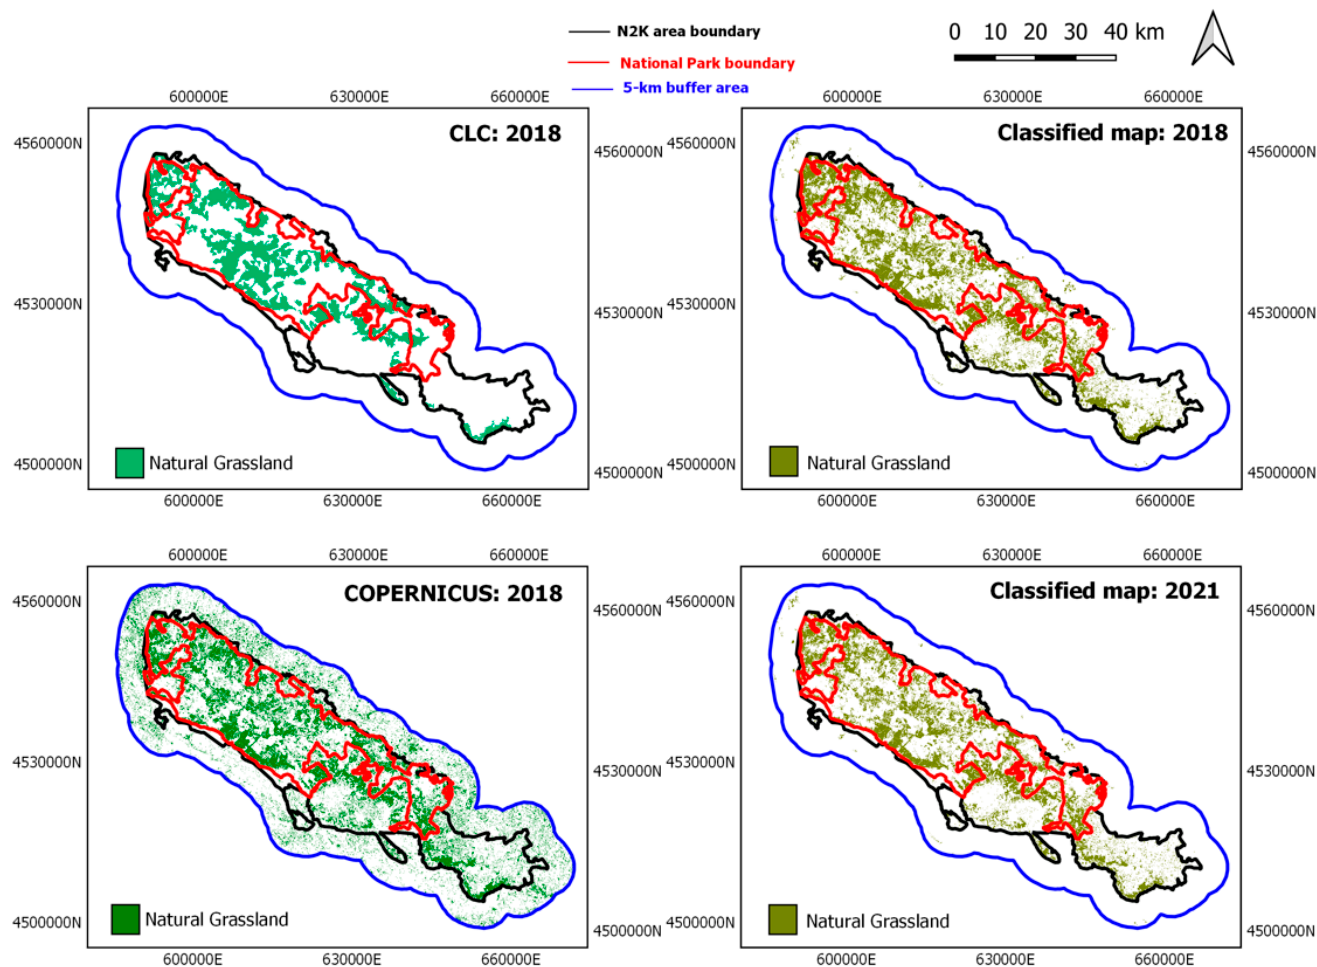
Figure 9. Grasslands classified mappings (10 m spatial resolution) for 2018 and 2021 on the top right vs. CLC mappings (100 m spatial resolution) and Copernicus HR grasslands layer (10-m spatial resolution) for 2018 on the bottom left.